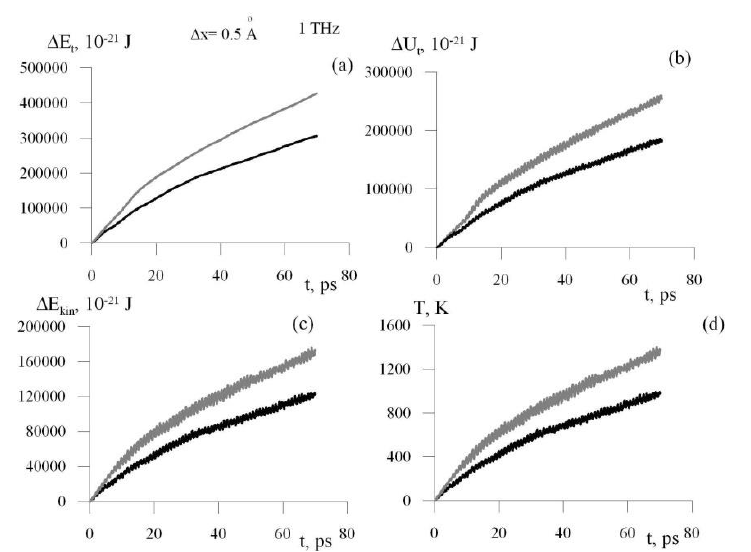
Fig. 9. Time dependence of the energy characteristics of the system: (а) – amplification of the total energy of the system; (b) – amplification of the potential energy взаимодействия atoms; (c) – amplification of the thermal energy; (d) – the temperature found via the energy of the thermal chaotic motion of atoms. Black line – perfect nanorod; grey line – amorphized nanorod.  x 0 = 0.5 Å,  =1 THz.